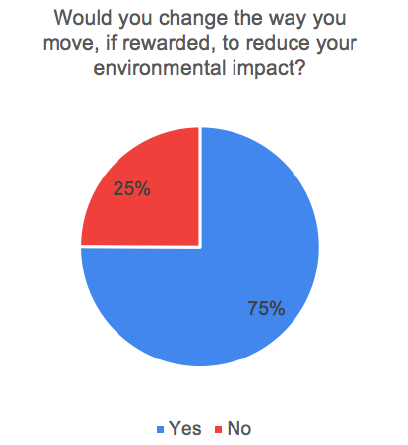
Fig. 2. People that would change their mobility habits, if rewarded. Generated from the survey (686